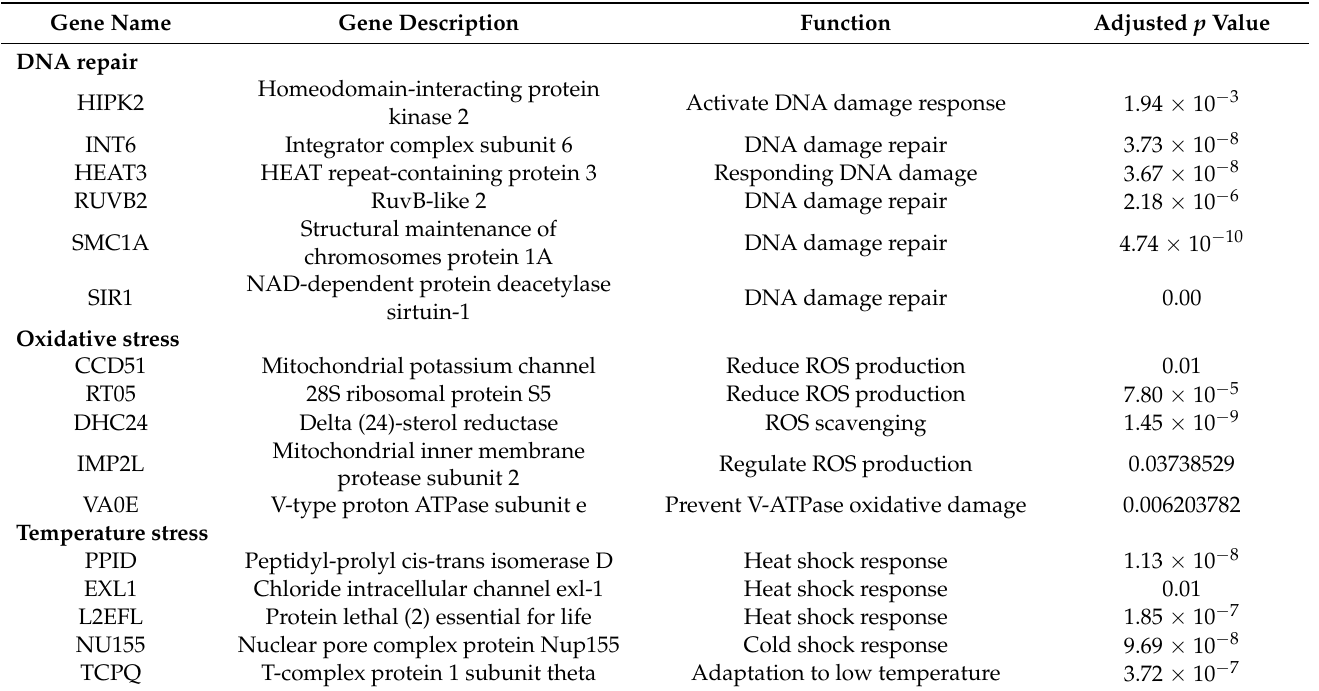
Table 4. Positively selected genes in S. leurokolos related to DNA repair, oxidative stress, and tempera- ture